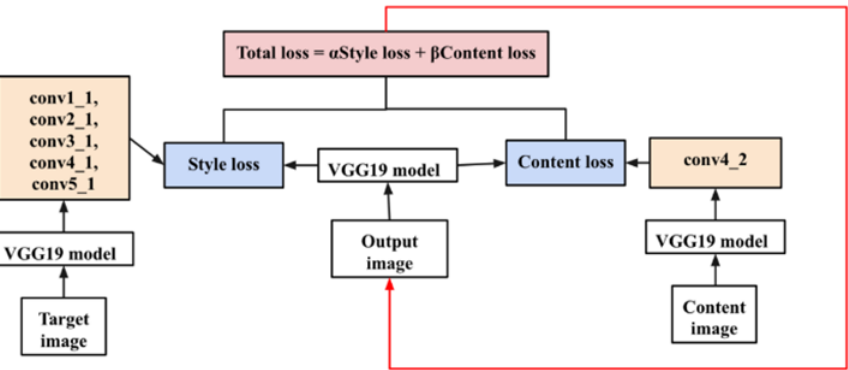
Figure 2. The architecture of image style transfer.